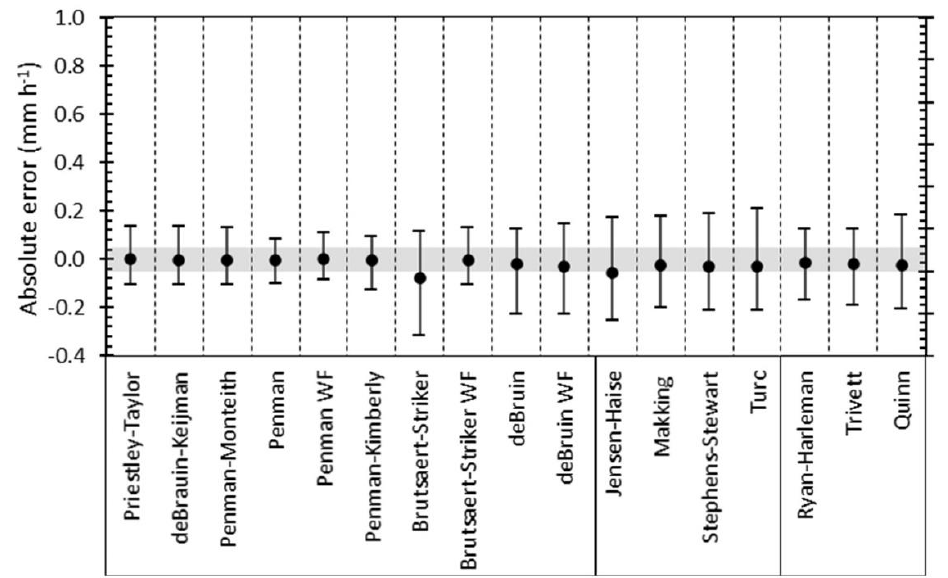
Figure 16. Maximum, minimum and average absolute errors between modeled and observed values for hourly models after applying K LL .